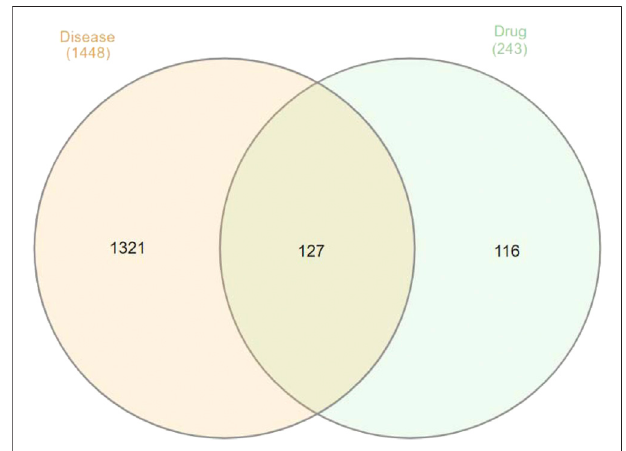
FIGURE1| Venndiagram oftheintersectionaltargetsofGuishao-Liujun decoction and